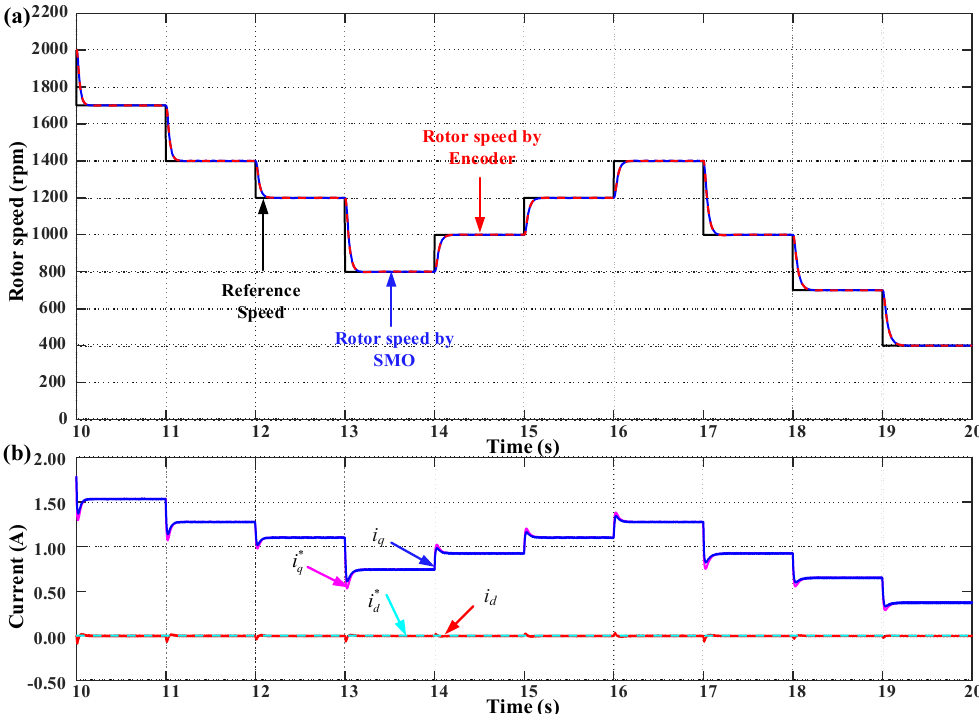
Figure 10. Simulation results in the speed decreasing strategy, from 2000 rpm to 400 rpm for ( a ) speed response, ( b ) current response.